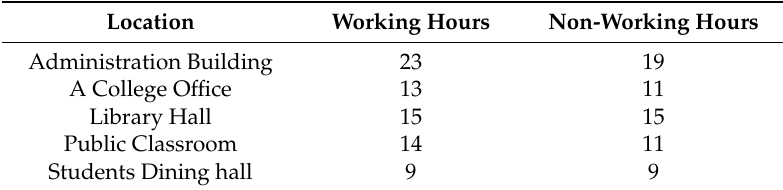
Table 1. Number of detectable APs in China University of Mining and Technology